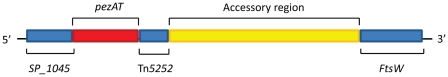
General component structure of PPI-1v.Summary of PPI-1v derived from alignments of the region between ATCC 700669, 1, 1861 and G54. Blue indicates regions of shared sequence between the aligned strains, red indicates the pezAT region and yellow indicates a region of divergent sequence (accessory region).